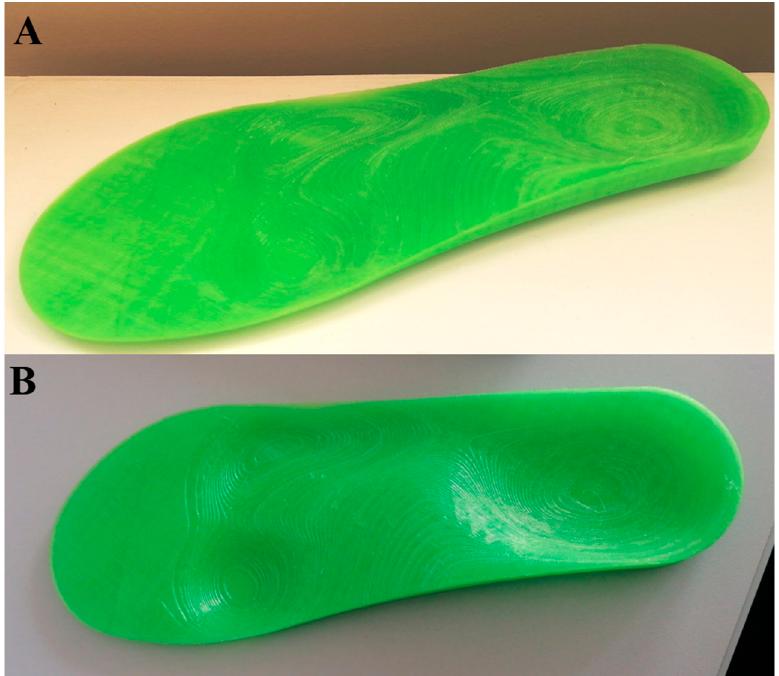
Figure 4. Right 3D-printed insole using thermoplastic polyether-polyurethane.